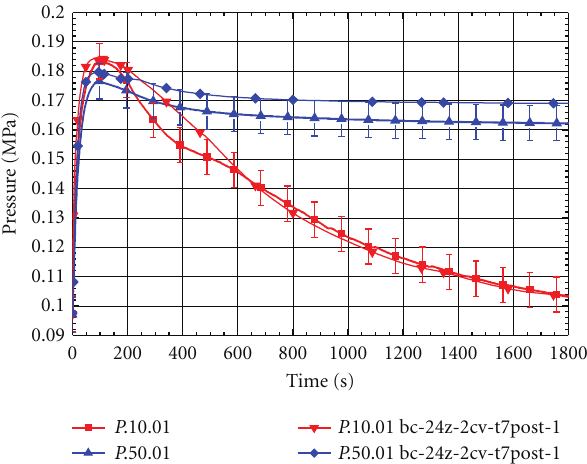
Figure 13: Measured and postcalculated absolute pressures in V 1 and V 5 boxes, Test